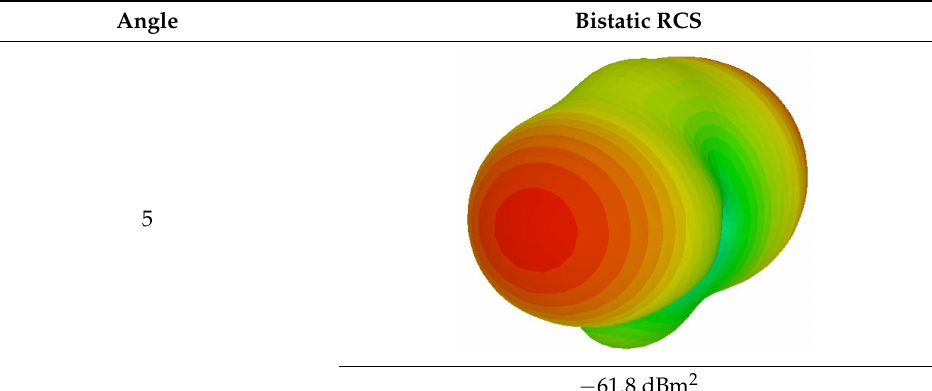
Figure 4. Sample of the tilted position of the proposed coding metamaterial. Table 7. Bistatic RCS scattering patterns of coding metamaterial with 8 lattices at 0.84 THz with various tilt